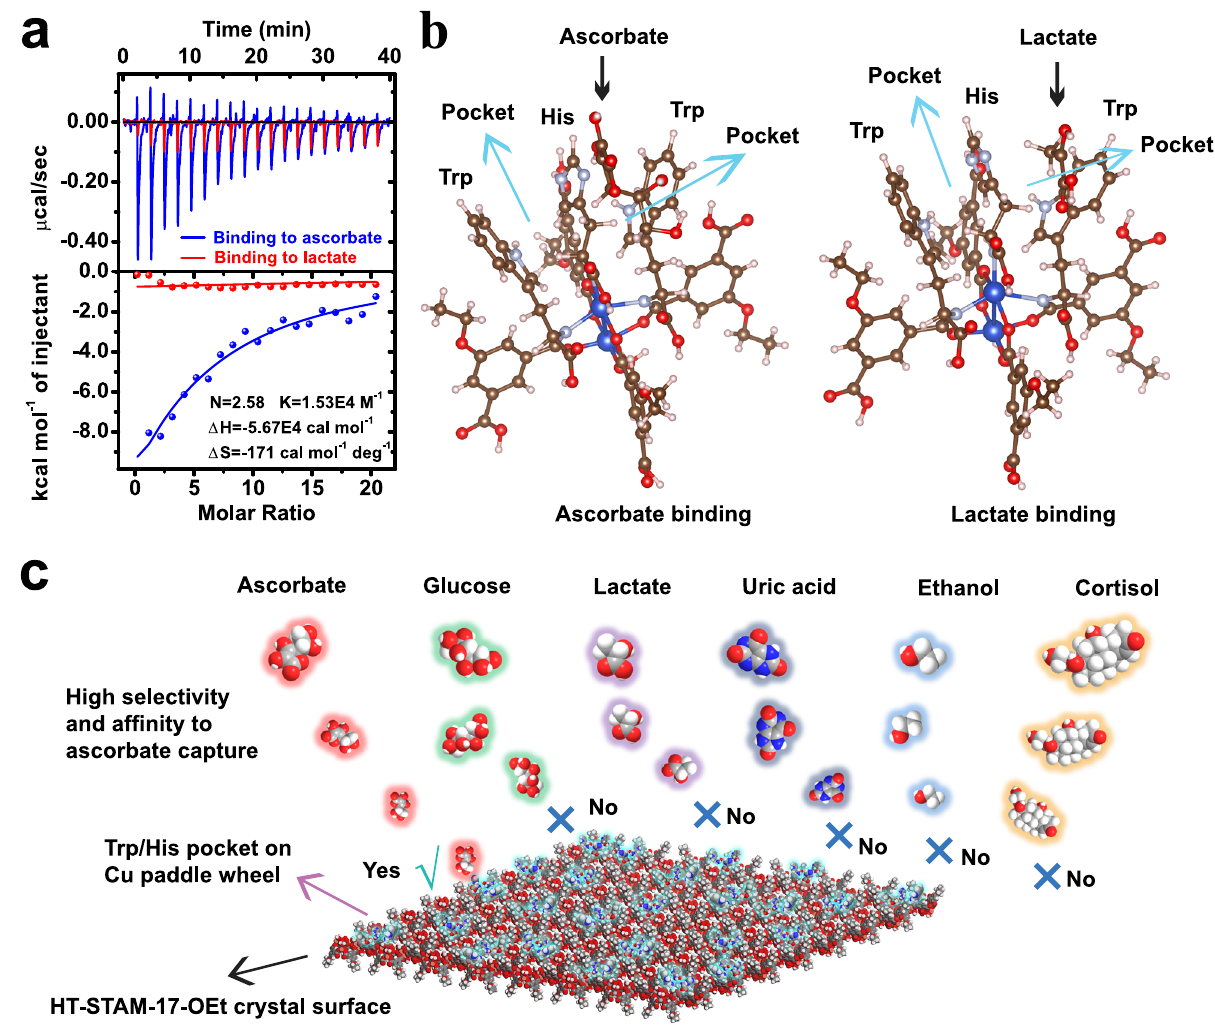
Fig. 4 | Speci fi c ascorbate recognition mechanism of HT-STAM-17-OEt. a ITC curvesofHT-STAM-17-OEtbindingtoascorbateandlactate. b Optimizedgeometric